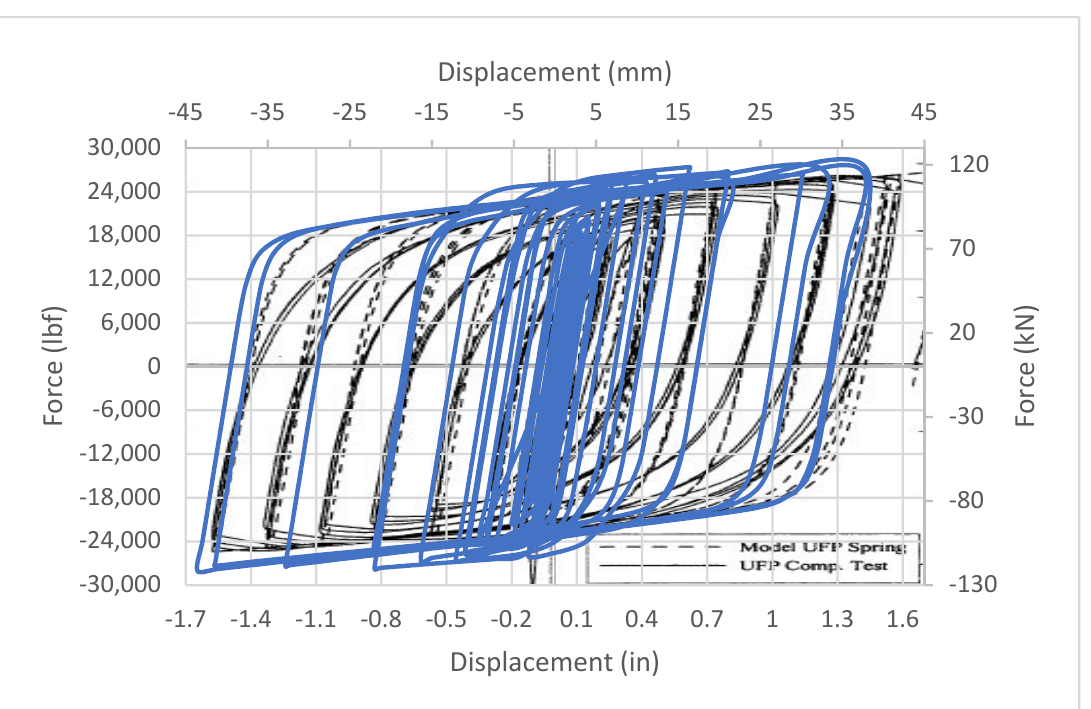
Figure 2. Finite elements model in ANSYS workbench: ( a ) meshed shape; ( b ) boundary condition.